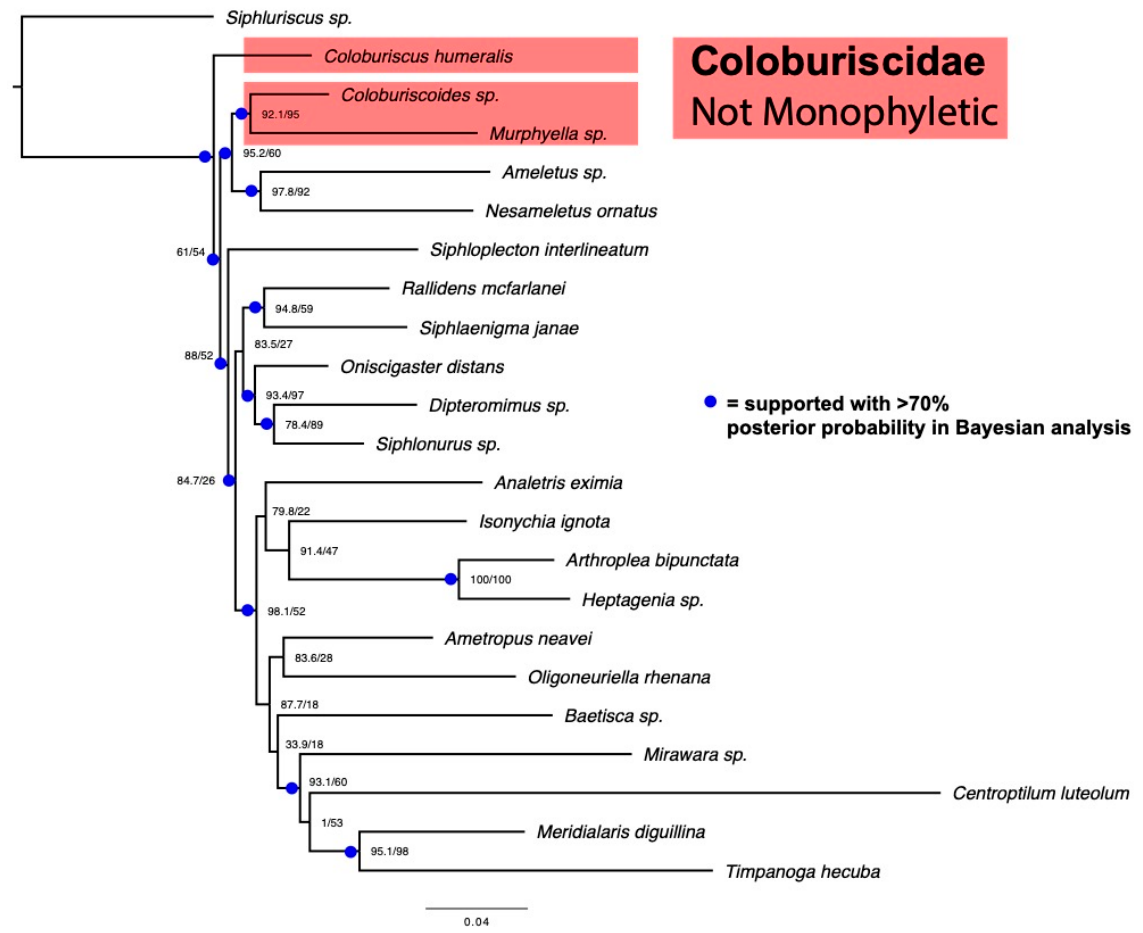
Figure 2. Maximum likelihood analysis of 5-gene Sanger dataset. Results show the non-monophyly of Coloburiscidae, highlighted in red. The blue circles indicate the nodes that were supported with >70% posterior probability in the Bayesian analysis. The numbers on the nodes are SH-aLRT support %/ultrafast bootstrap support %.